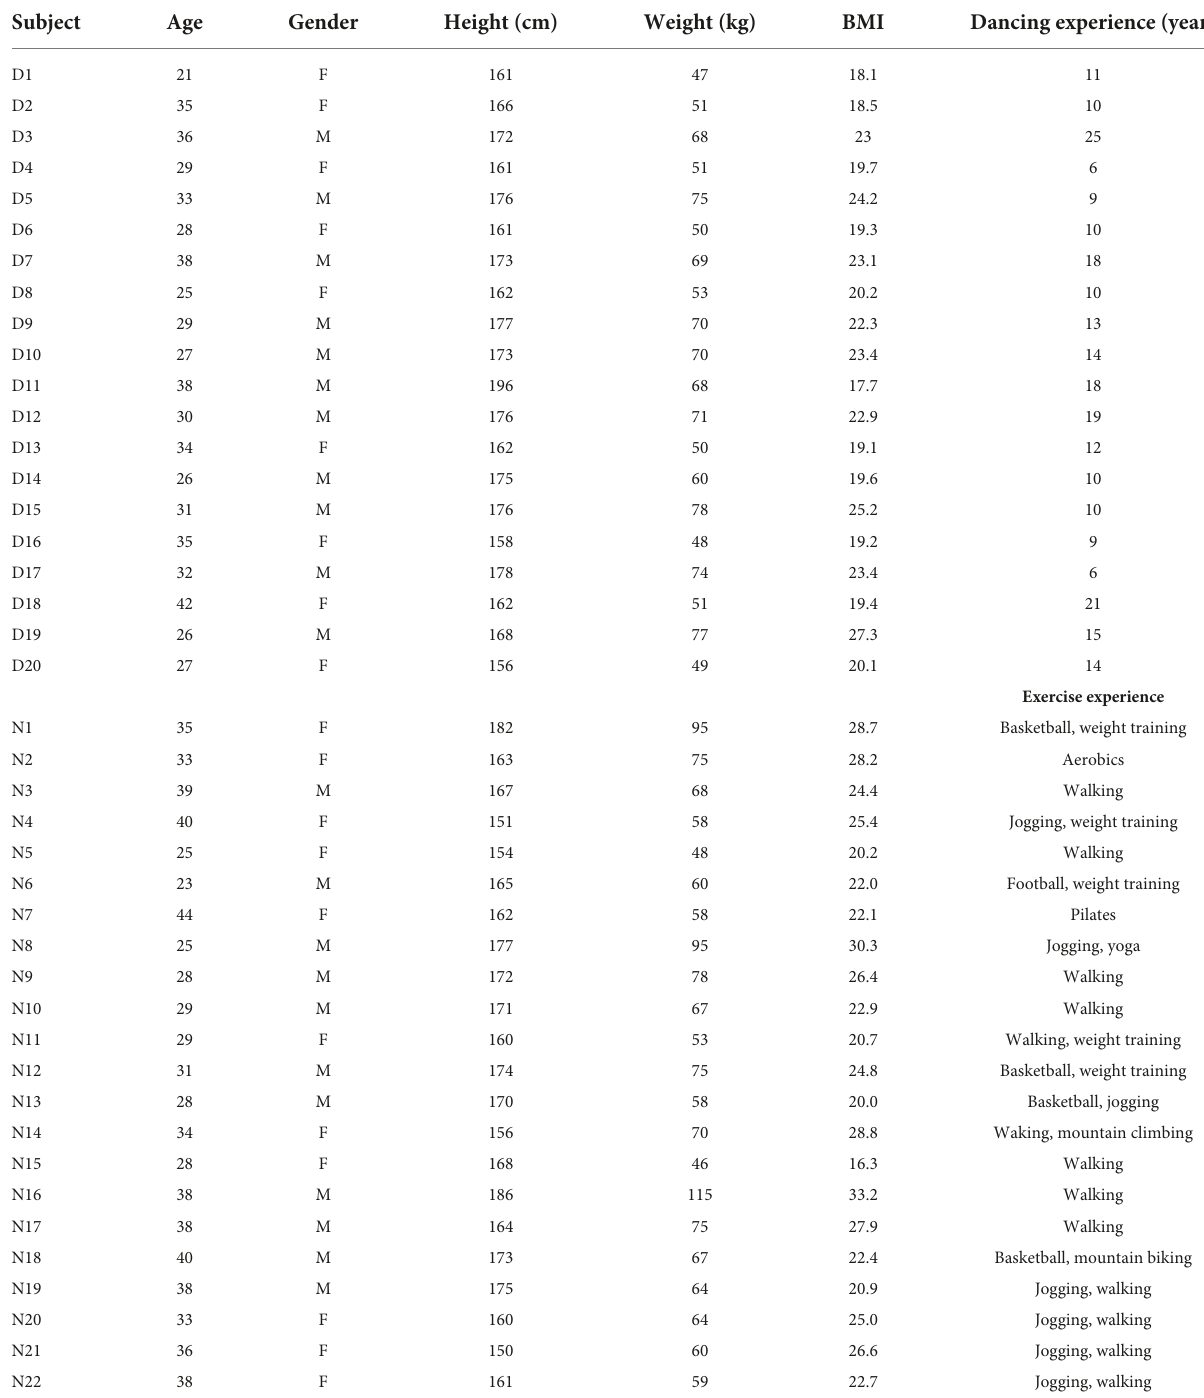
TABLE 1 Basic data of the